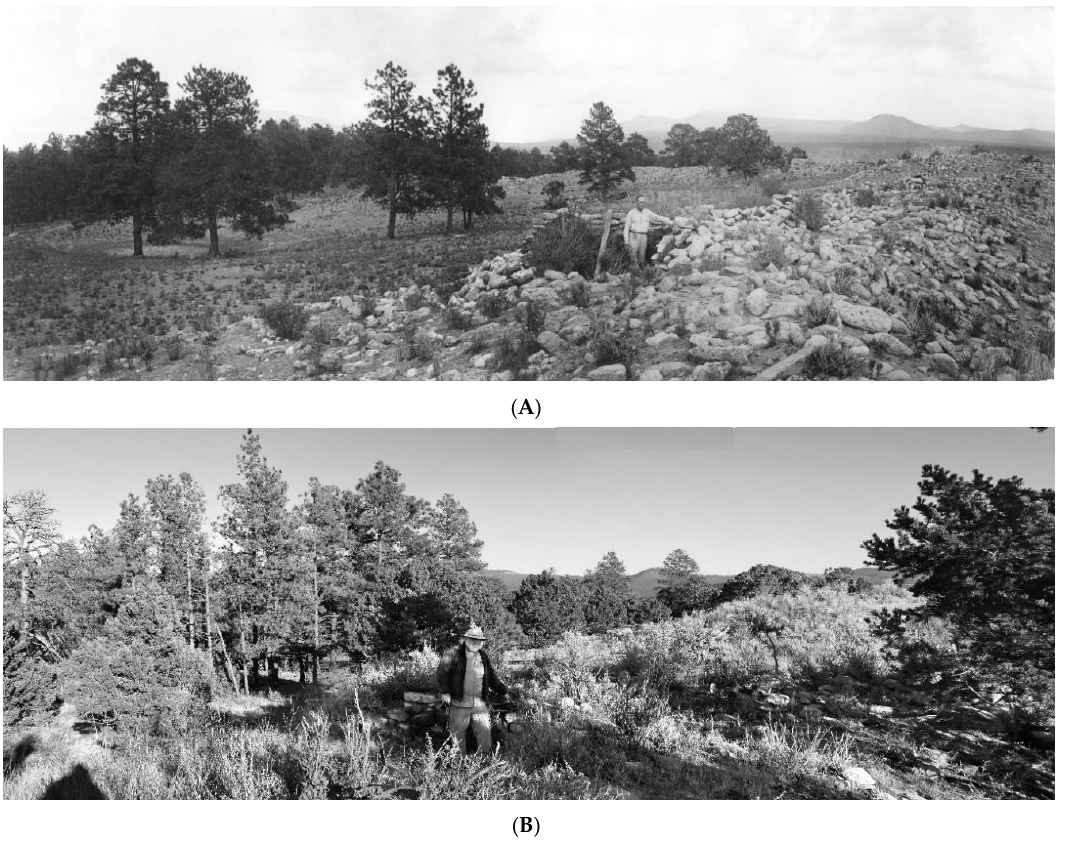
Figure 2. Repeat photographs of the changing fuel load at the comparable ruin of Amoxiumqua